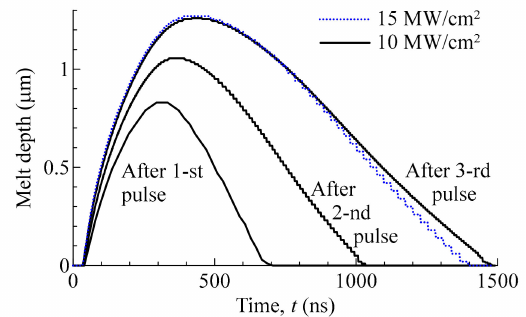
Figure 9. Melt depth in the target at single pulse laser processing with I max = 15 MW / cm 2 and multipulse processing with I max = 10 MW / cm 2 and inter-pulse separation 10 µ